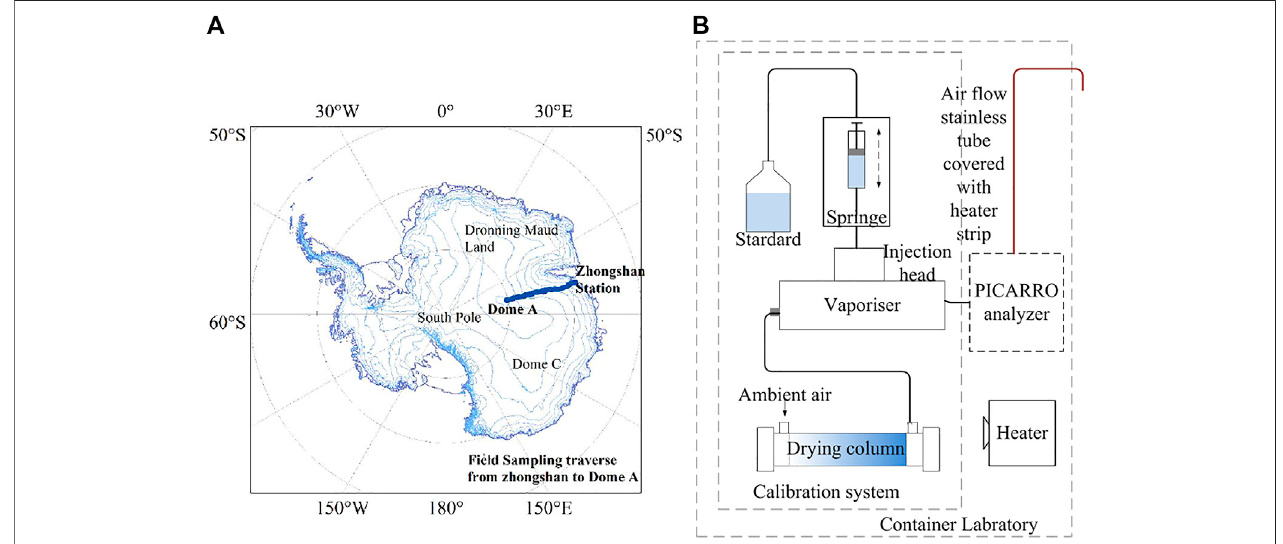
FIGURE 2 | Humidity-induced bias calibration during the fi eld measurement.